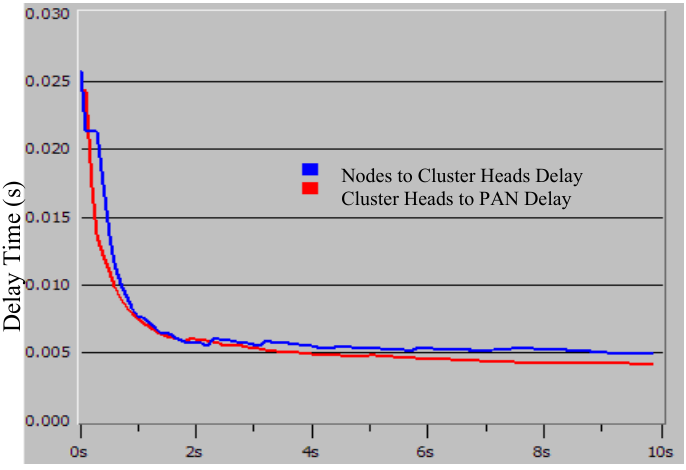
Figure 9. The simulation result for network delay with 16 nodes and four cluster